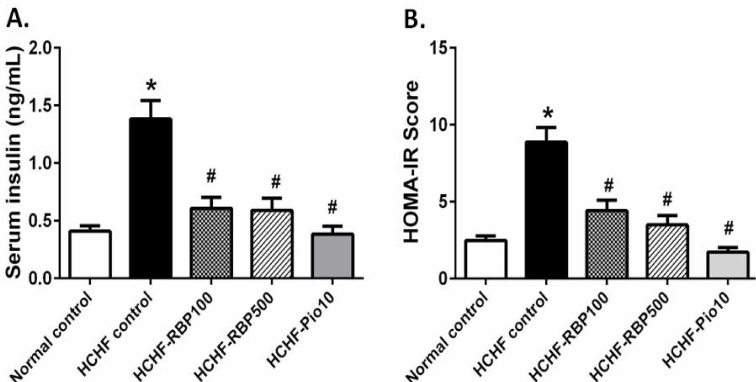
Figure 2. Effects of RBP on serum insulin levels ( A ) and HOMAR-IR values ( B ) in HCHF-fed rats. Oral administration of RBP 100 or 500 mg/kg or pioglitazone 10 mg/kg daily for 6 weeks significantly decreased serum insulin and HOMA-IR. ( * : p < 0.05, significant increase as compared to normal controls; # : p < 0.05, significant decrease as compared to HCHF-control group, n = 7/group).